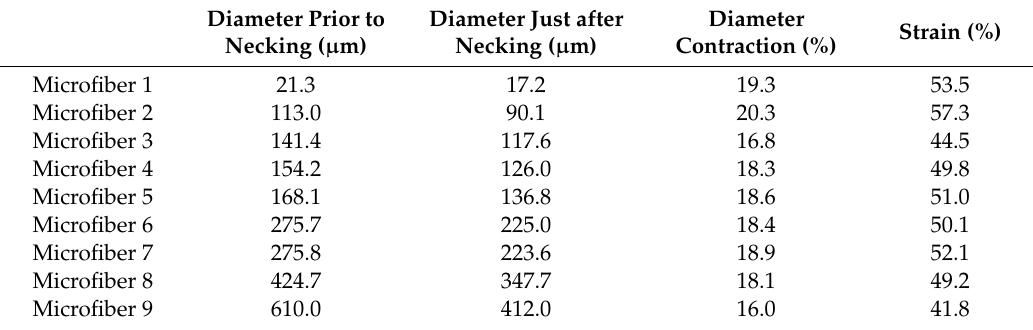
Table 1. Calculation of the diameter contraction of several microfibers and the theoretical calculation of the strain due to the necking according to Equation (1).